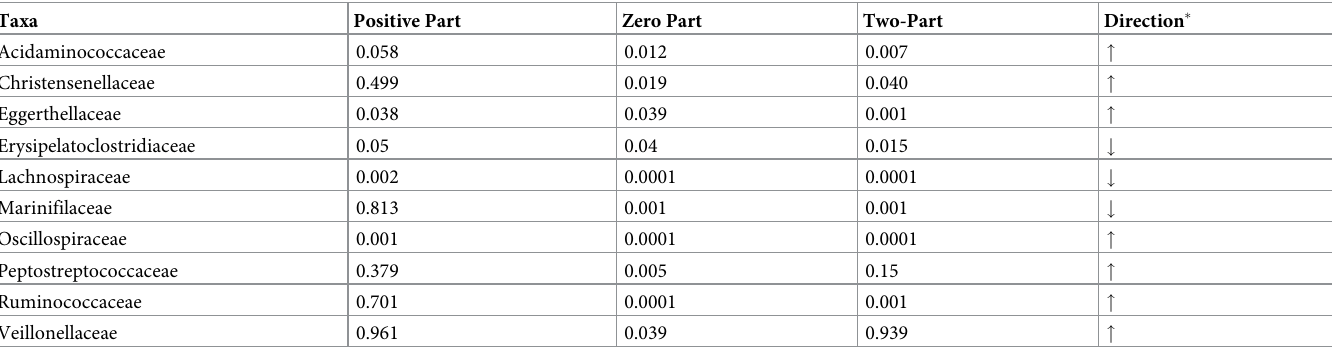
Table 7. Bacterial taxa associated with HEI scores among those with gastrointestinal symptoms adjusted for GWI status at the family level.